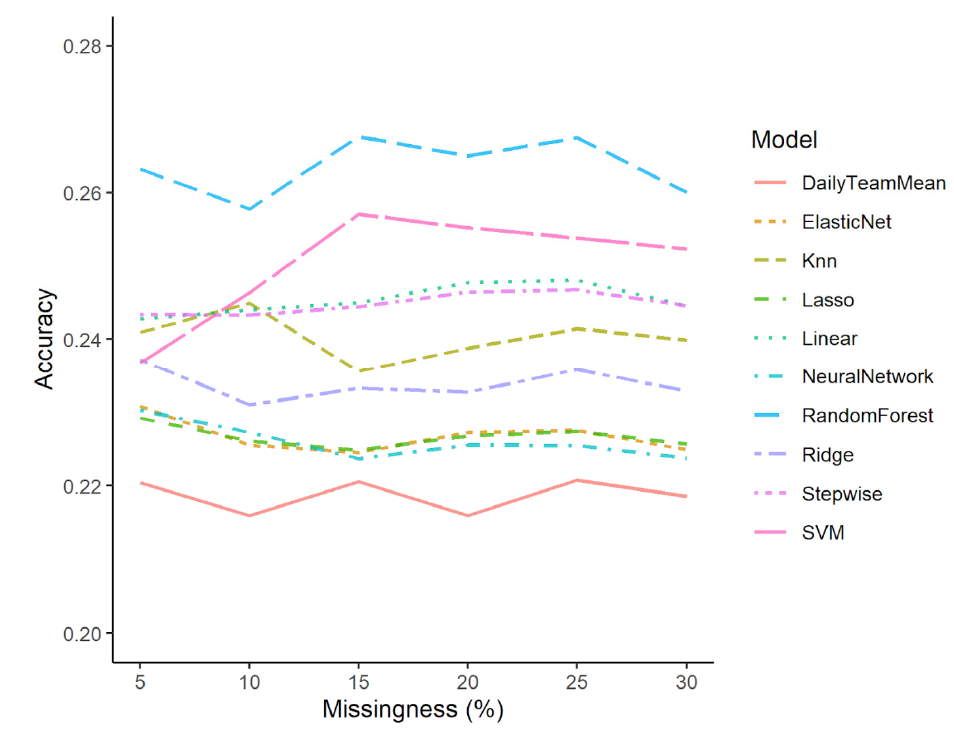
Figure 3. Model accuracy by data missingness from 10–50% missingness. The one-way ANOVA of the slope of the supervised regression found statistically significant differences in slope by model type ( F (9, 1454) = 1.93, p < 0.05), and by level of missingness ( F (6, 1454) = 2.83, p < 0.05). A Tukey post hoc revealed that the daily team mean substitution and neural network model types were significantly different than all other models across all levels of missingness, including the complete dataset (0% imputed data).